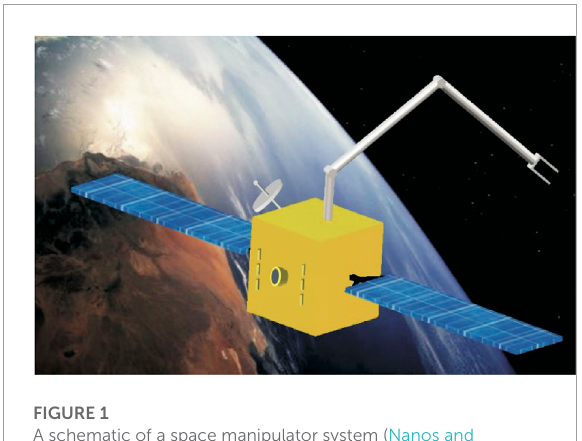
FIGURE 1 A schematic of a space manipulator system (Nanos and Papadopoulos,